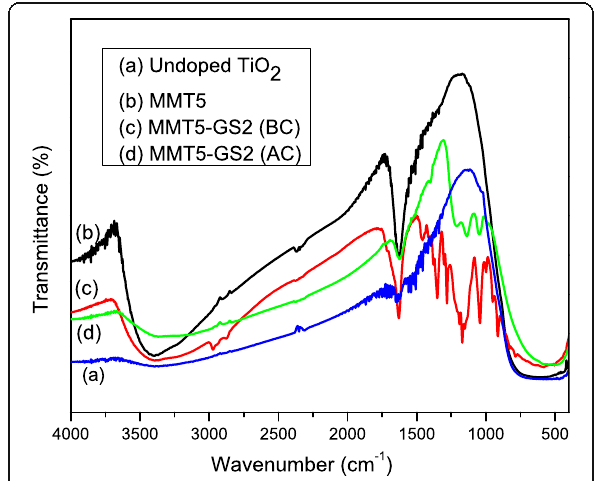
Fig. 7 a FT-IR spectra of undoped TiO 2 , b MMT5, c MMT5-GS2 (before calcination), d FT-IR spectra of MMT5-GS2 (after